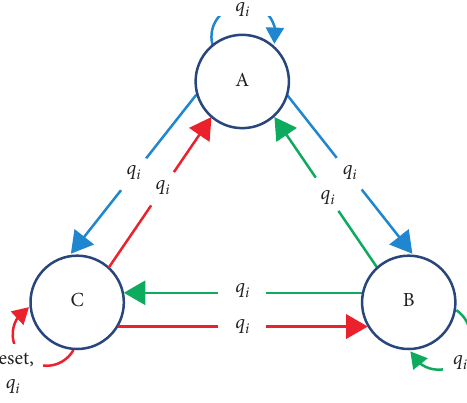
Figure 9: The state chain diagram with q